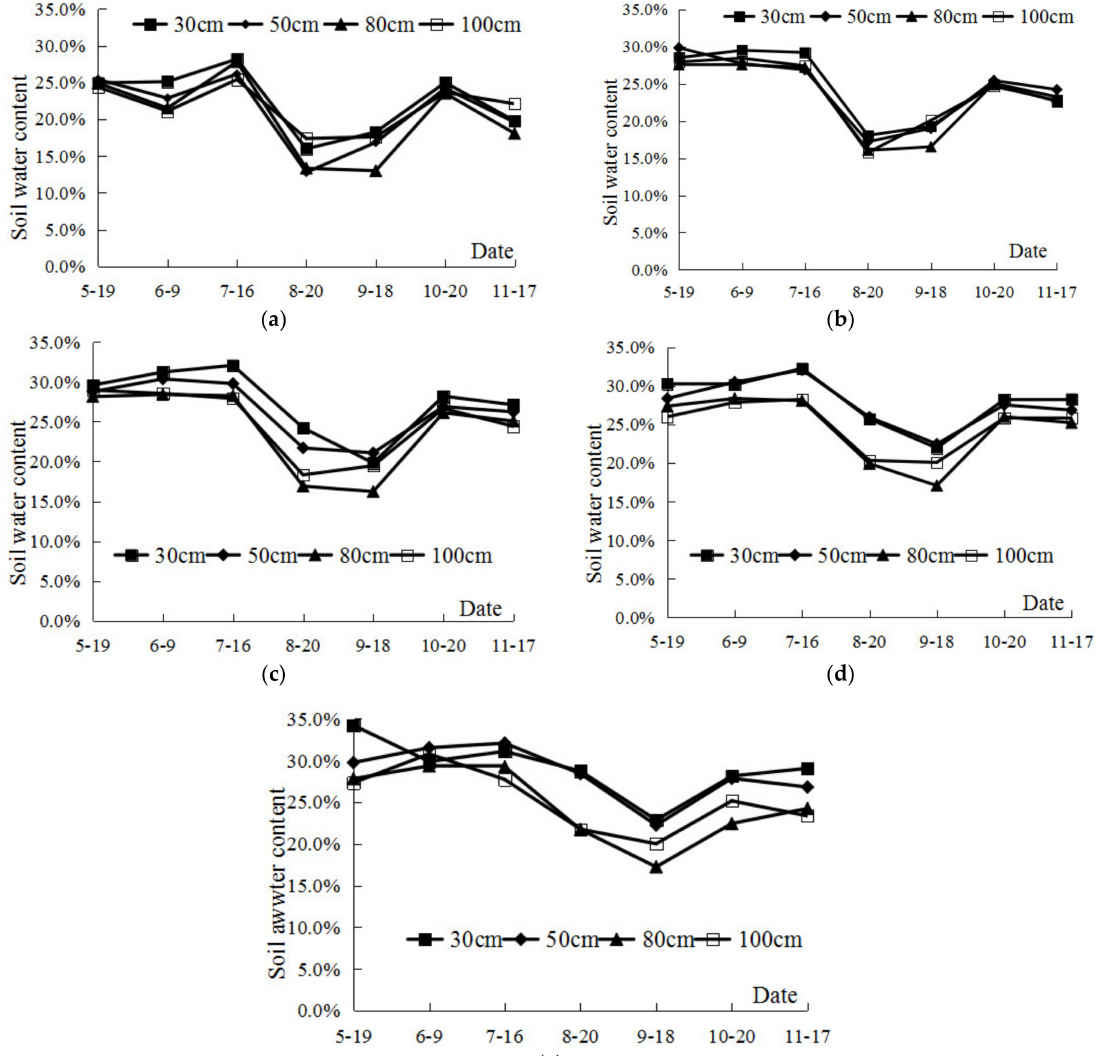
Figure 6. Variation in the soil water content in the different layers during the cotton growth period in the test pits in 2010. ( a ) Soil water content at the surface; ( b ) Soil water content in the 20 cm layer; ( c ) Soil water content in the 40 cm layer; ( d ) Soil water content in the 60 cm layer; ( e ) Soil water content in the 80 cm